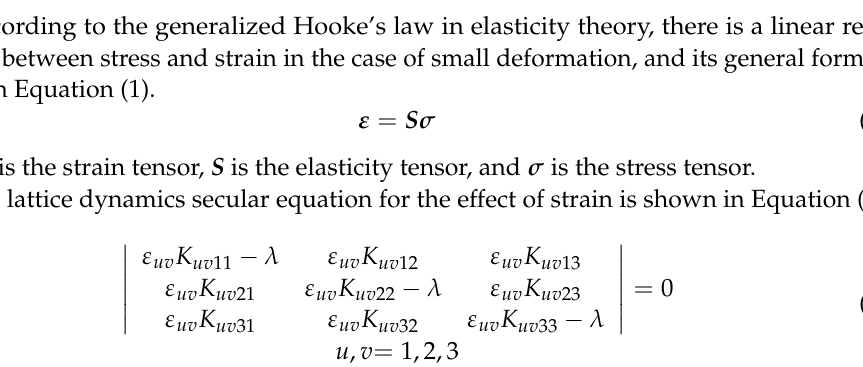
Figure 2. General Raman-stress relationship model building flow chart.